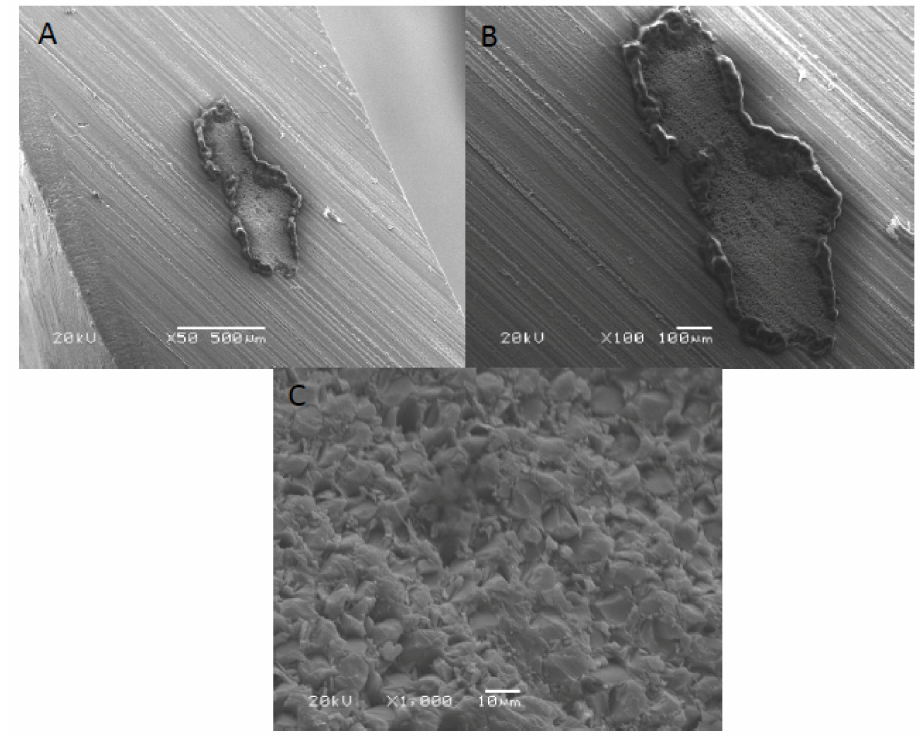
Figure 5. SEM images of OCT fibers (group 2) at ( A ) × 50, ( B ) × 100 and ( C ) × 1000 magnification.